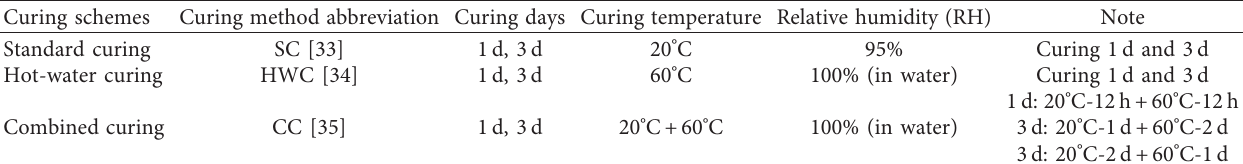
Table 6: Curing schemes of